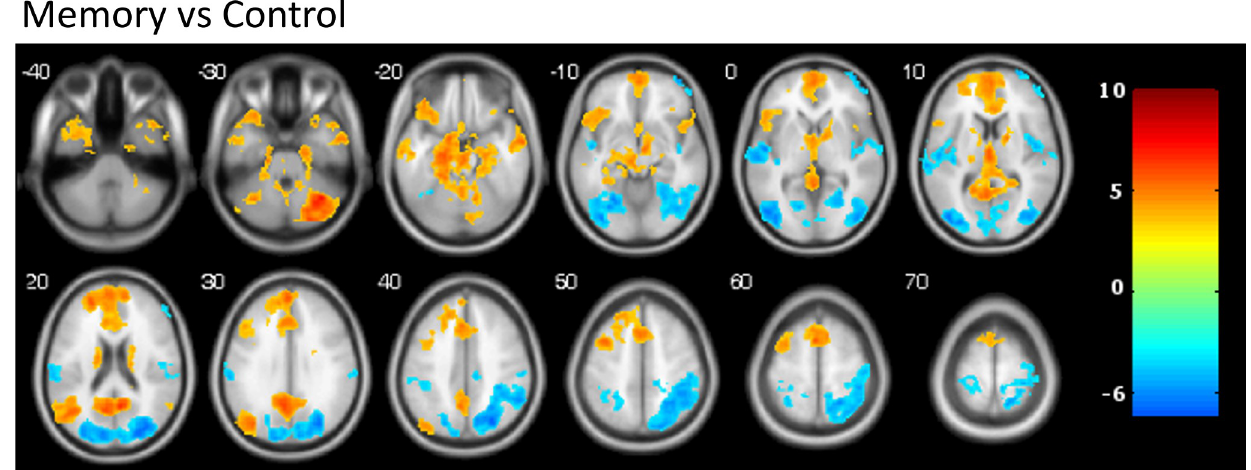
Fig 1. Activation map for the autobiographical memory task. Warm colors represent memory > control contrast, cold colors represent control > memory contrast. Numbers indicate z coordinate in MNI space. Images are displayed in neurological convention (right is right). Color bar depicts Z